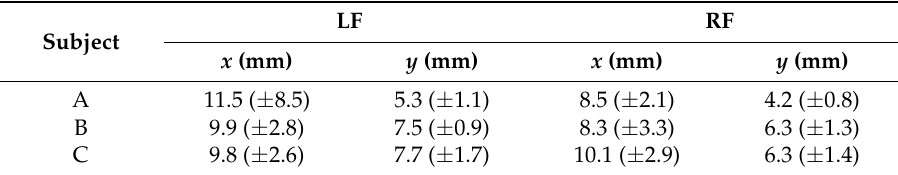
Table 4. Root-mean-square error (RMSE) of center of pressure (COP) comparing measurements from the Nintendo Wii Balance Board (WBB) with those from the force plate while walking straight.